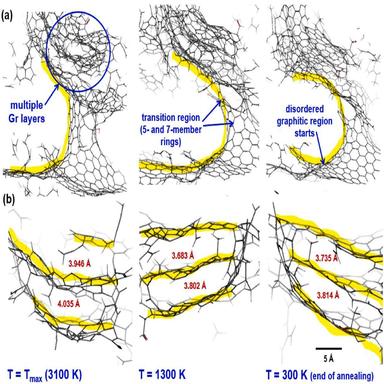
Shown here is a close-up view of the hybrid material's final nanostructure where extended annealing and long holding time at maximum temperature produced a more pronounced closed cage-like GrGC nanostructure evolution during ramp-down of temperature. (a) change in curvature of the GrGC nanostructures with annealing (b) stacking of Gr layers also gets more defined with annealing. At the end of annealing, the mean Gr interlayer stacking reached ~3.77 Å at 300 K. The shorter annealing case (GrGC0 ) also showed